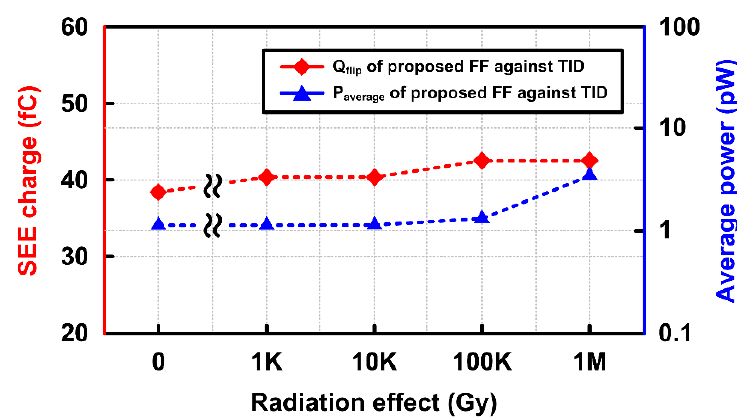
Figure 18. Flip charge ( Q flip ) and the average power of the proposed flip-flop depending on TID levels.